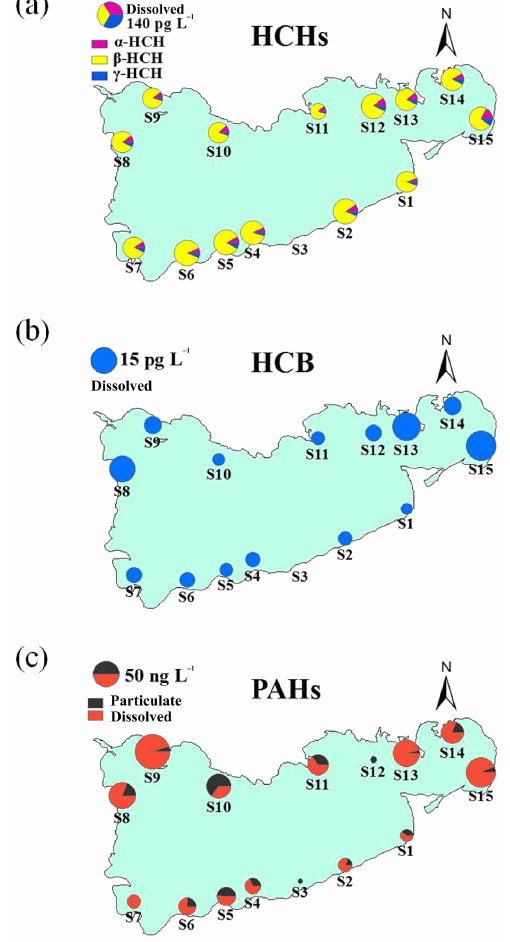
Figure 4. Spatial distribution pattern of HCHs (a) , HCB (b) , and PAHs (c) in the surface water of Nam Co